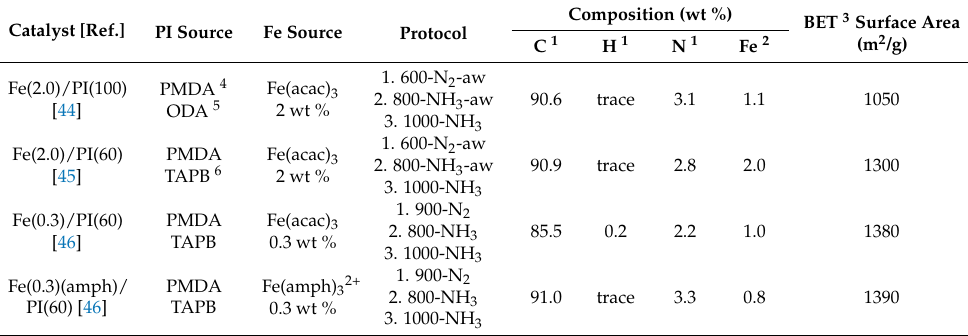
Table 1. Details of the catalysts prepared with various precursors and protocols.